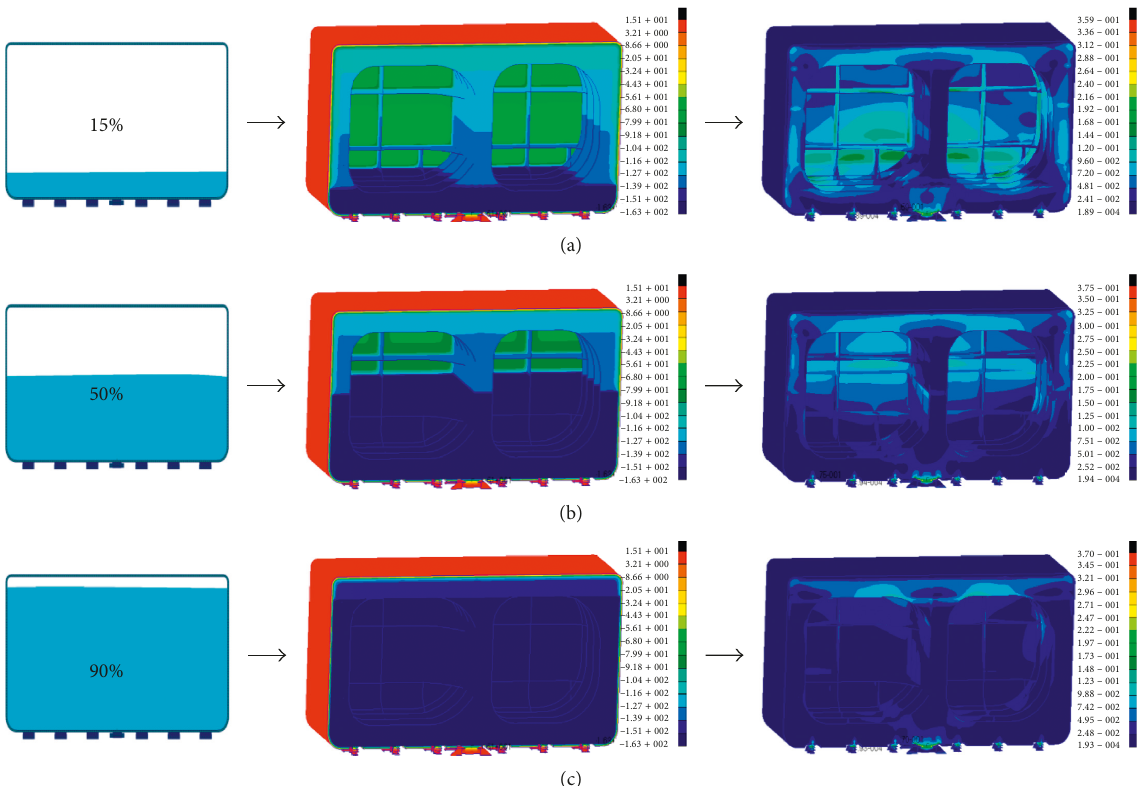
Figure 6: Temperature distribution and thermal stress distribution of the LNG fuel tank with (a) 15%, (b) 50%, and (c) 90% filling